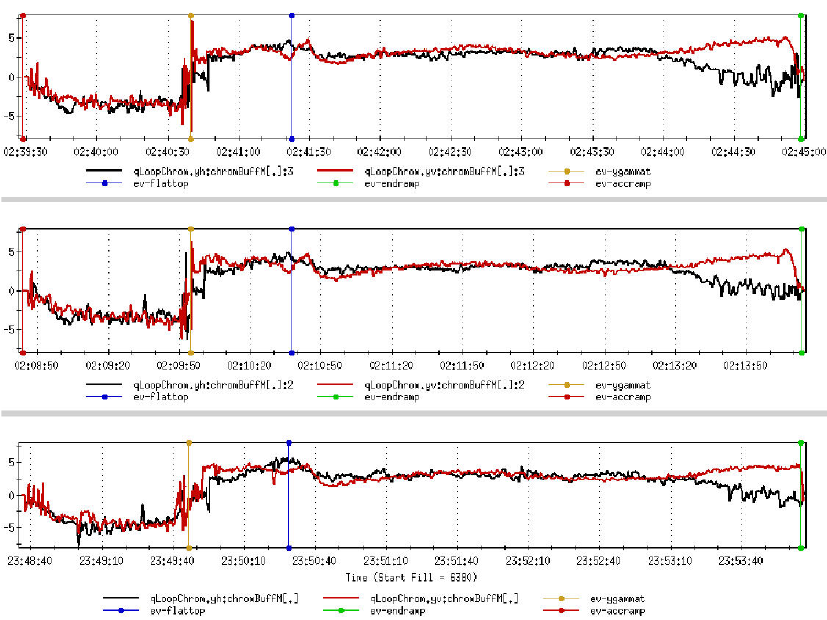
FIG. 14. (Color) Automated chromaticity measurement during three successive